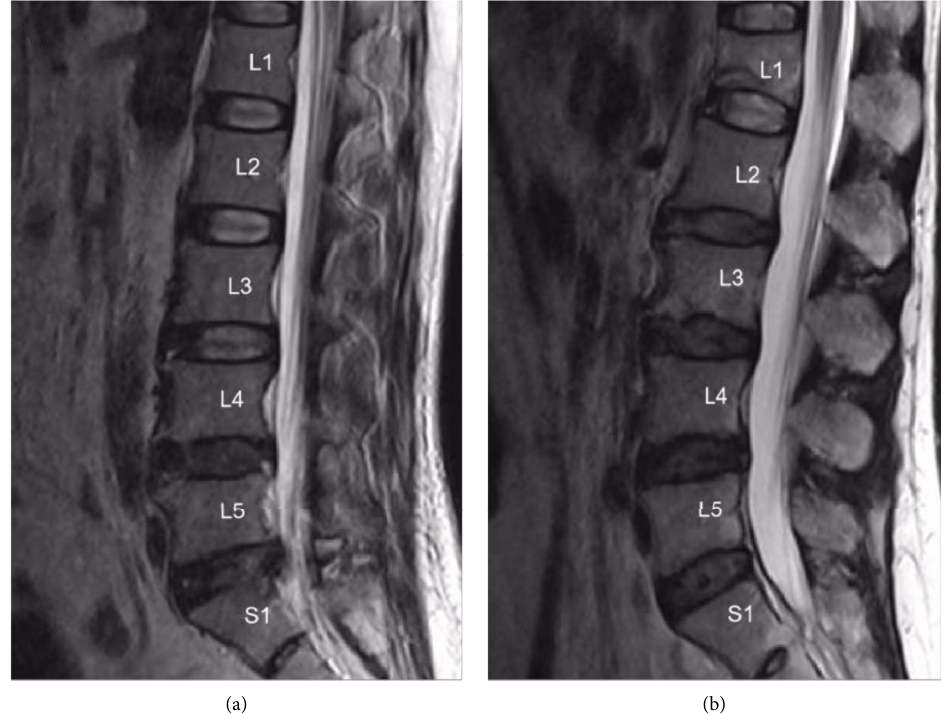
Figure 2: MRI T2-weighted sagittal images were used to assess the degree of IVDD at the L1/L2–L5/S1 levels by the modified Pfirrmann grading system. (a) The modified Pfirrmann grading scores from L1/2 to L5/S1 were 2, 2, 3, 4, and 4 for a patient in the non-TAM group, respectively. (b) The modified Pfirrmann grading scores from L1/2 to L5/S1 were 2, 4, 4, 4, and 4 for a patient in the TAM group, respectively.